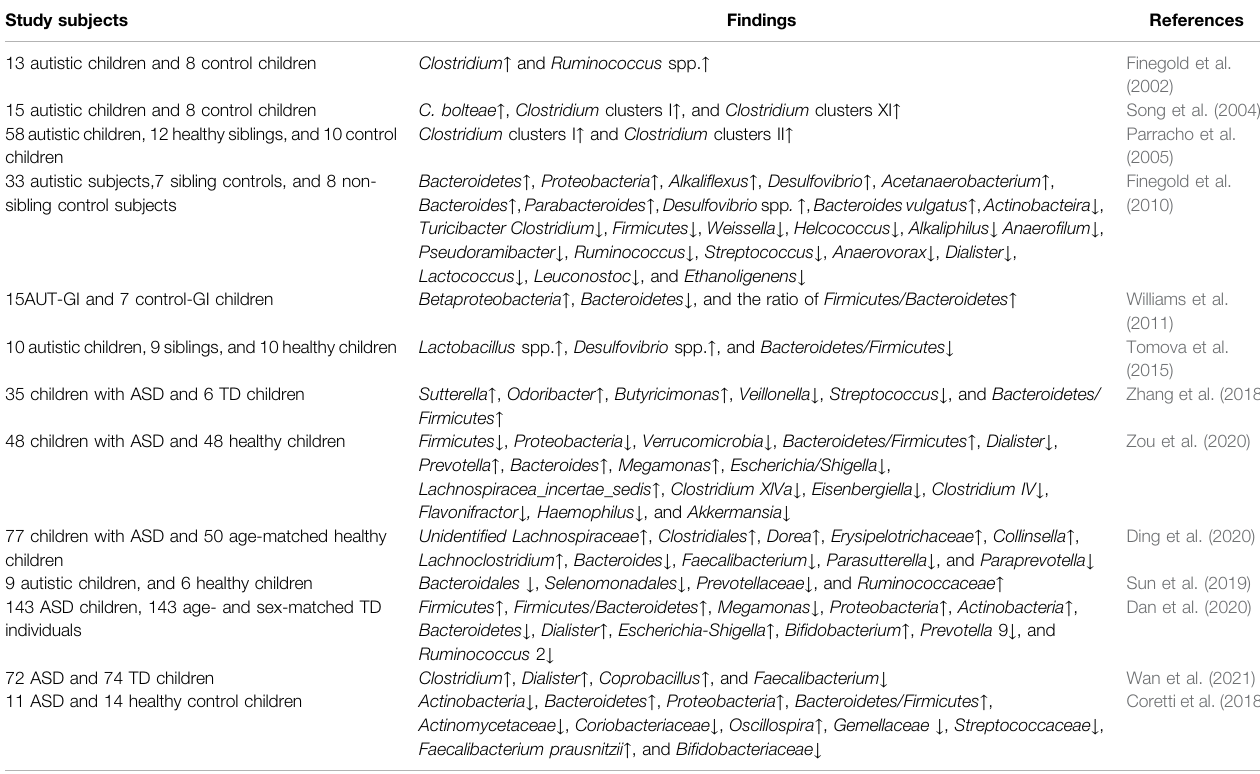
TABLE 2 | Altered gut microbiota composition in ASD patients ( ↑ = increased, ↓ =